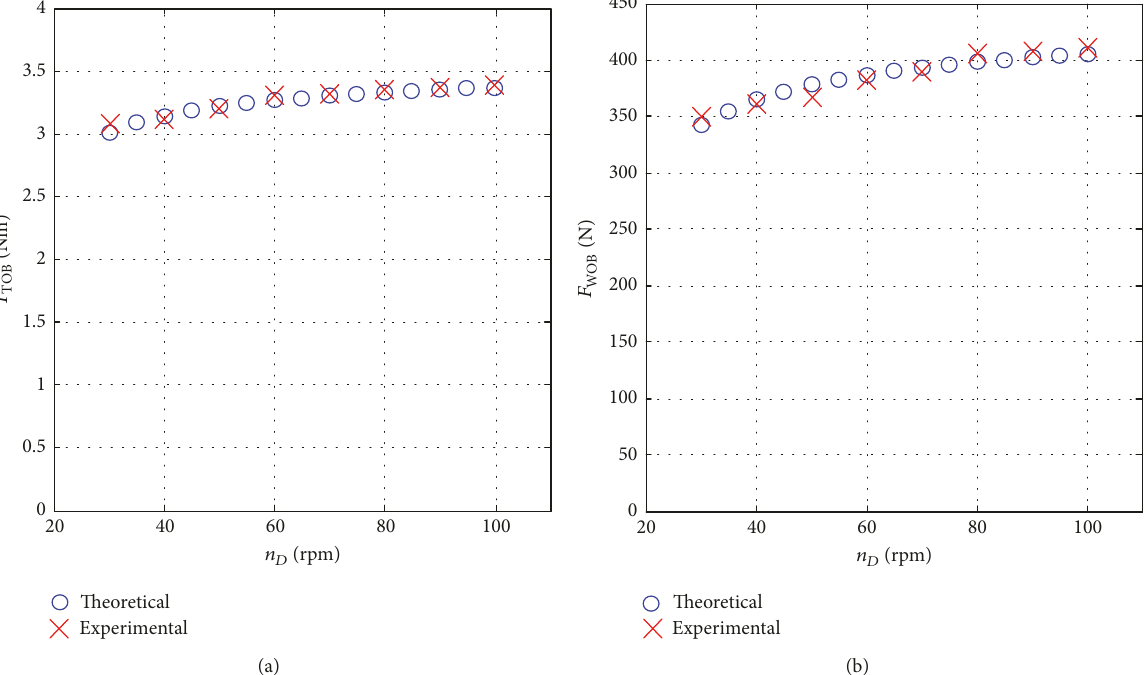
loads applied to the lunar rock simulant by the bit in each rotation cycle of the drilling process, that is, the decrease in the blow per revolution decreases the proportion of fracture due to impact-cutting coupling for the lunar rock